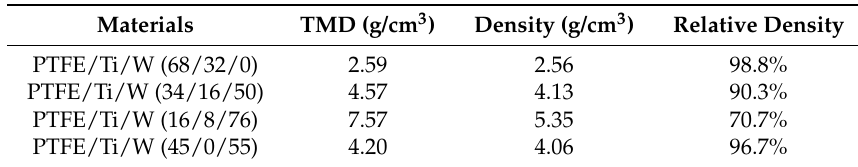
Table 1. Material properties of experimental samples. PTFE: polytetrafluoroethylene; TMD: theoretical maximum density.